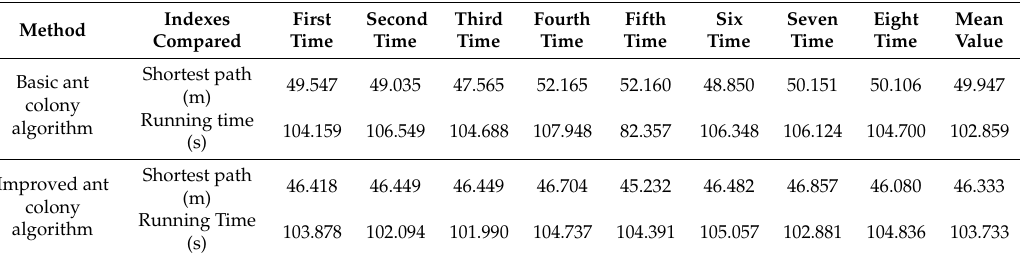
Table 3. The running data of the second